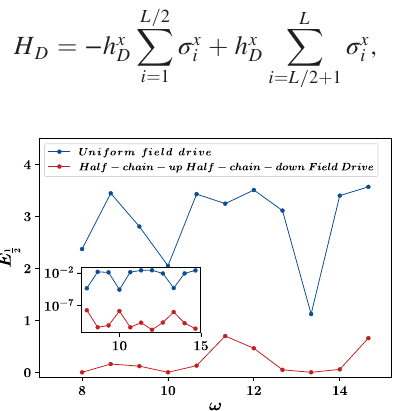
10. Freezing of the entanglement growth of the L= 2 - domain-pair x -basis state under a half-up half-down field drive [Eq. (C1)]. The fate of a fully polarized state under the same drive is also shown for comparison. The main frame shows E 1 while the inset shows m x , averaged over 10 4 cycles, after driving for 10 10 cycles. The results are for J ¼ 1 ; κ ¼ 0 . 7 ; h x e= 10 ; h x 40 ; L ¼ 14 D ¼ 0 ¼